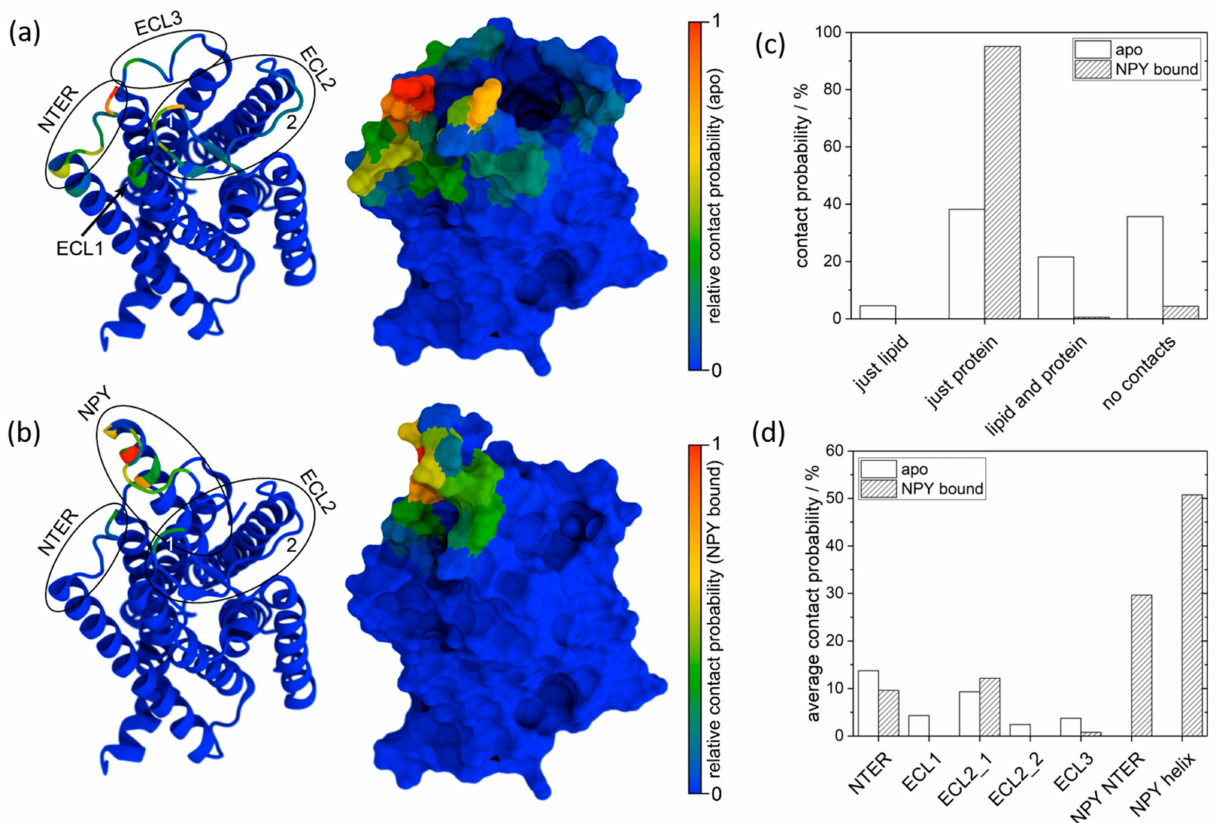
Figure 5. Projection of the number of contact instances onto the protein surface of apo Y2R-A202C-CrA ( a ) and the Y2R-A202C-CrA/ NPY complex ( b ) in cartoon (left) and surface (right) representations according to the indicated color scales. Note that the color scales in ( a , b ) were both normalized individually and are thus not directly comparable. The probability of contact between xenon and all system components is shown in ( c ) for apo Y2R-A202C-CrA (white) and the Y2R-A202C-CrA/ NPY complex (striped). The probabilities of contact with the different receptor sites observed in ( a , b ) are quantified in ( d